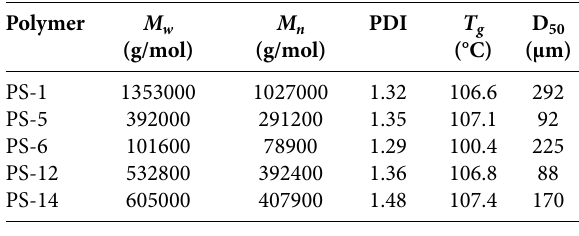
Table 2. Representative GPC, thermal analysis and particle size analysis results of synthesized polymers. Polymer